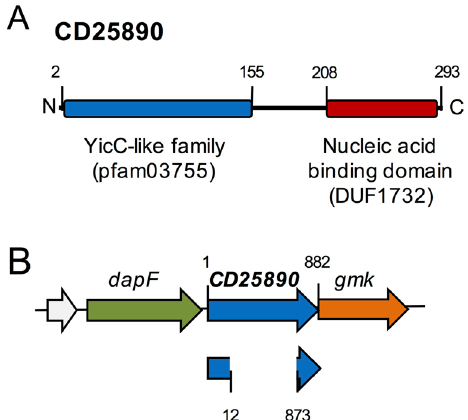
Figure 1. Sporulation and the CD25890 protein. ( A ) Schematic representation of the organization predicted for the CD25890 protein. CD25890 belongs to the YicC-like family of proteins (residues 2–155) and at the C-terminal has a domain that is predicted to bind to nucleic acids (residues 208–293). ( B ) schematic representation of the CD25890 (CD25890) region of the C. difficile 630∆ erm chromosome. The (cid:31) CD25890 in-frame deletion removed codons 5–291 of the